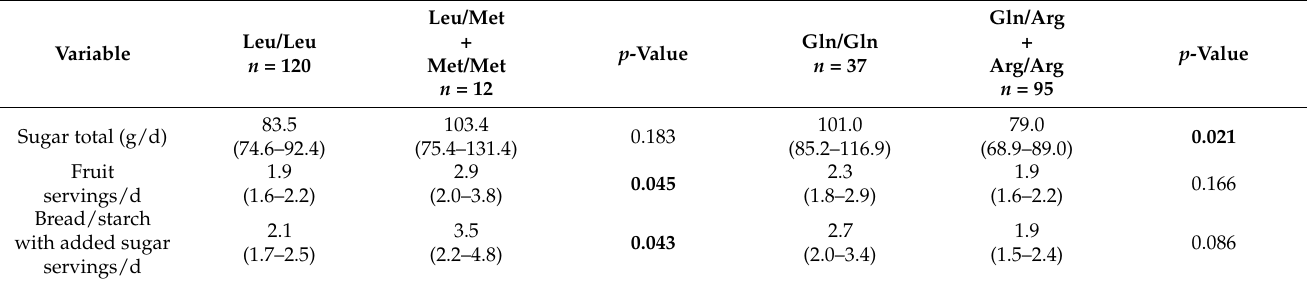
Table 3. Nutrient intake according to Leu72Met of GHRL and Gln223Arg of LEPR